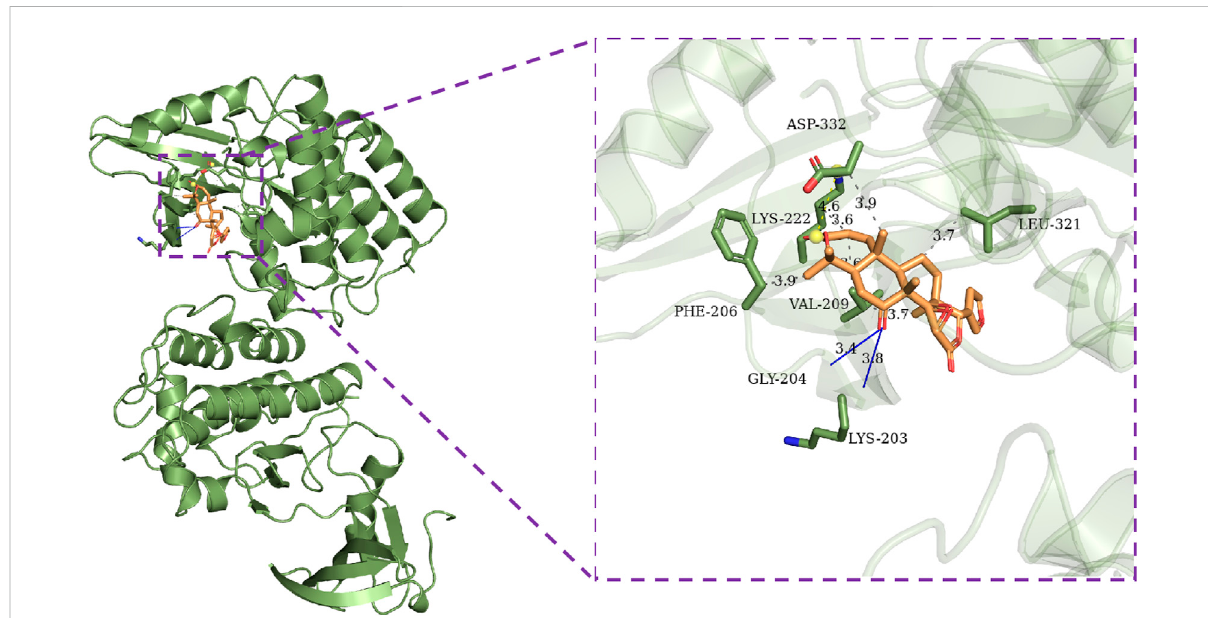
FIGURE 8 MoleculardockingresultsofObacunonewithSRC(1BYG).Graydashedlinesrepresenthydrophobicinteractions,bluelinesrepresenthydrogen bonding interactions, and yellow dashed lines represent salt